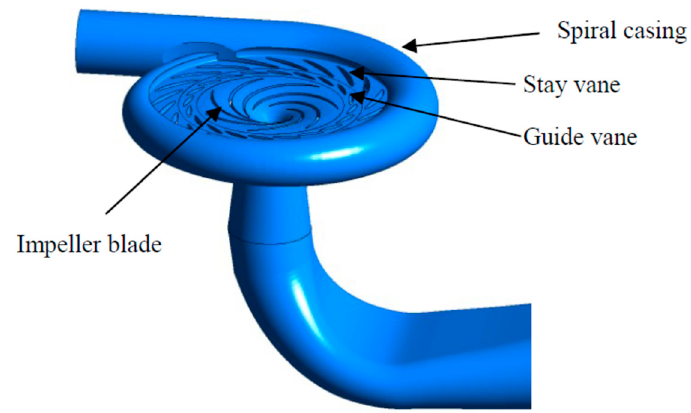
Figure 1. The 3D schematic map of the pump-turbine model shown as a fluid domain.